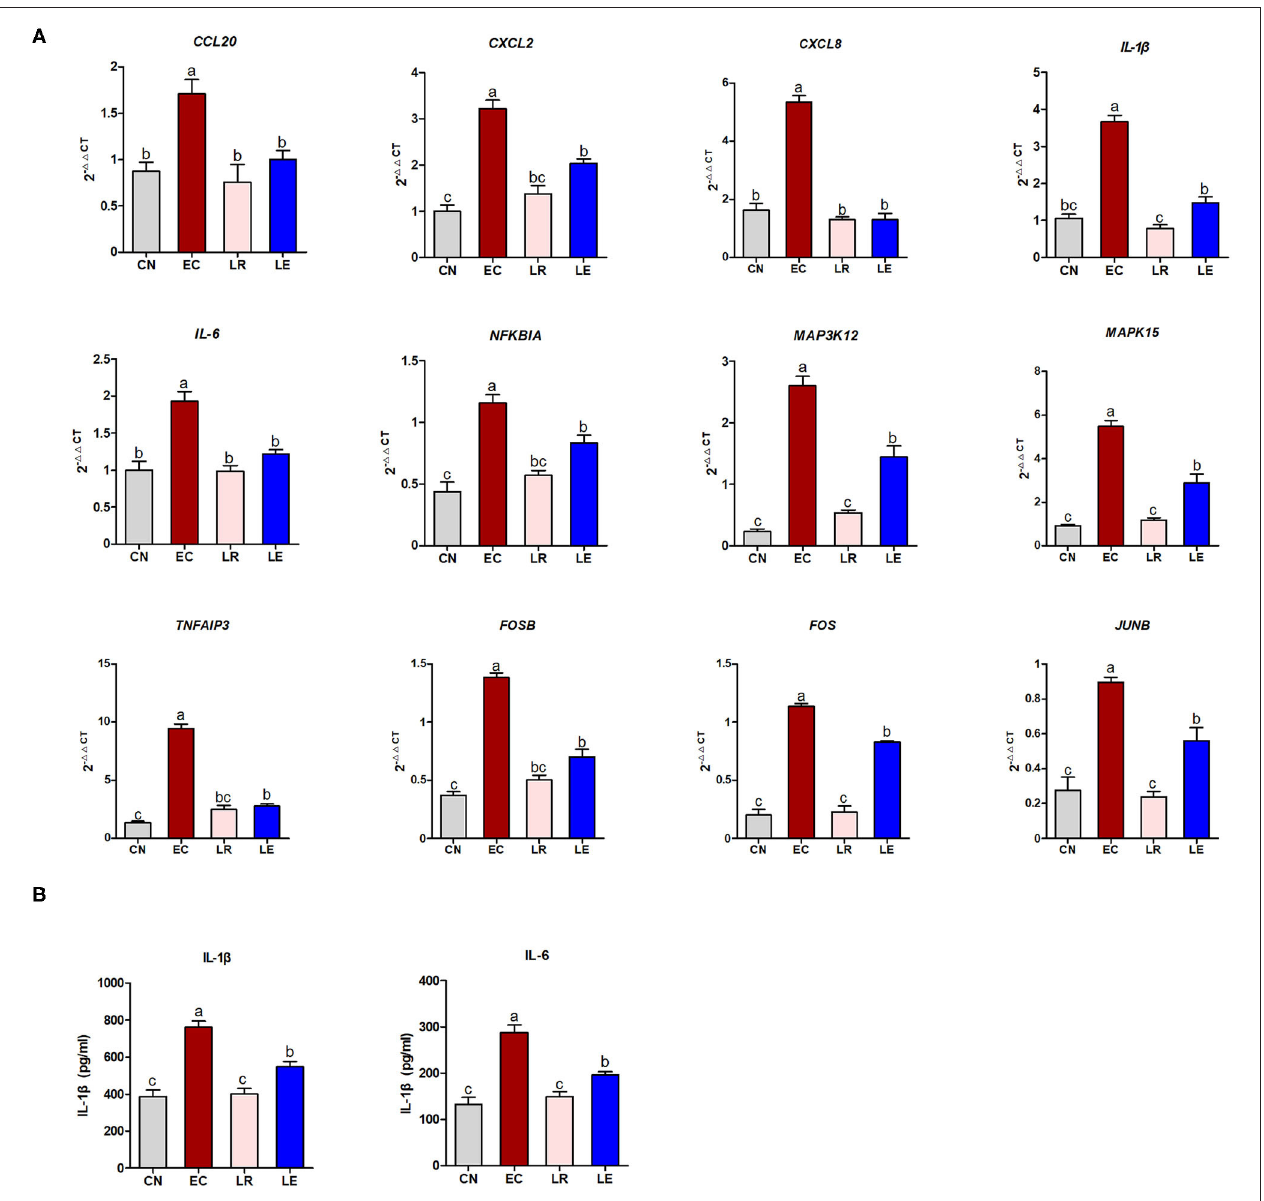
FIGURE 8 | qRT-PCR and ELISA validation of selected DEGs. (A) qRT-PCR was performed to validate immune response-related 12 selected DEGs. (B) ELISA was performed to measure concentration of IL-1 β and IL-6.